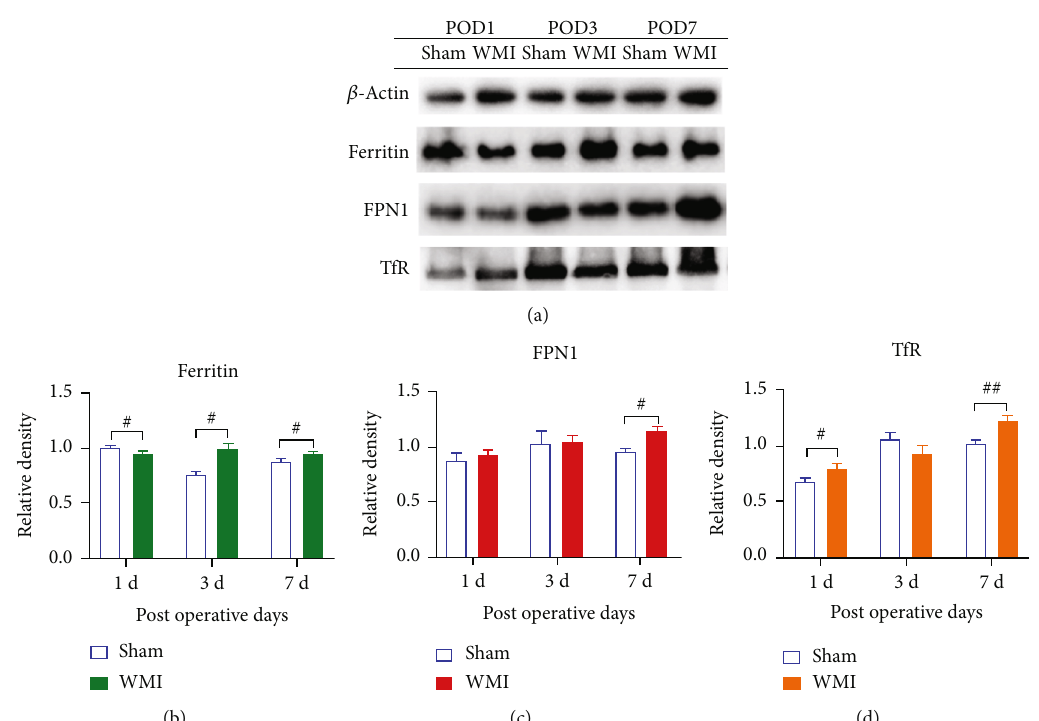
Figure 2: E ff ect of hypoxia-ischemia on the expression of ferritin, FPN1, and TfR in brain tissue on PODs 1, 3, and 7. (a) Bands of Western blots from brain tissue. (b – d) Relative protein expression of ferritin, FPN1, and TfR ( # p < 0 : 05 and ## p < 0 : 01 vs. sham group, n = 4